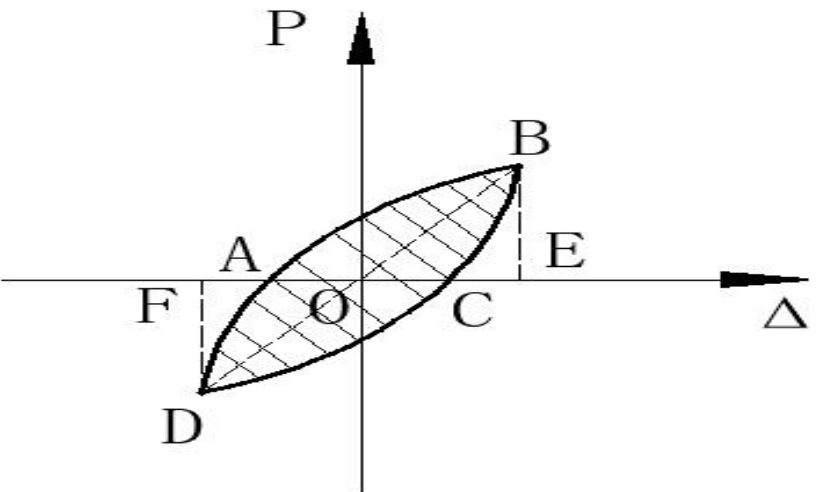
Figure 12. Calculation of equivalent viscous damping.